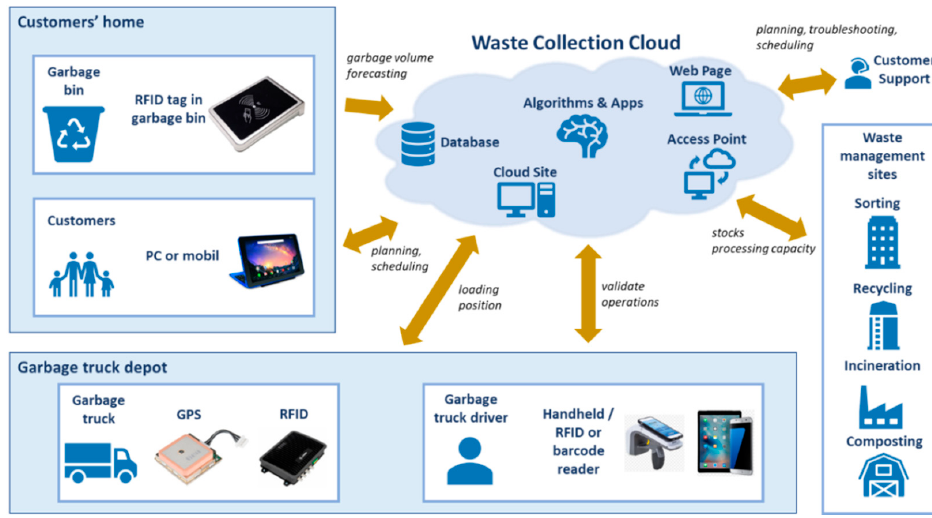
Figure 9. The Waste Collection Cloud and its connections with the cyber-physical waste collection system including customers, garbage trucks, waste management sites and customer support.